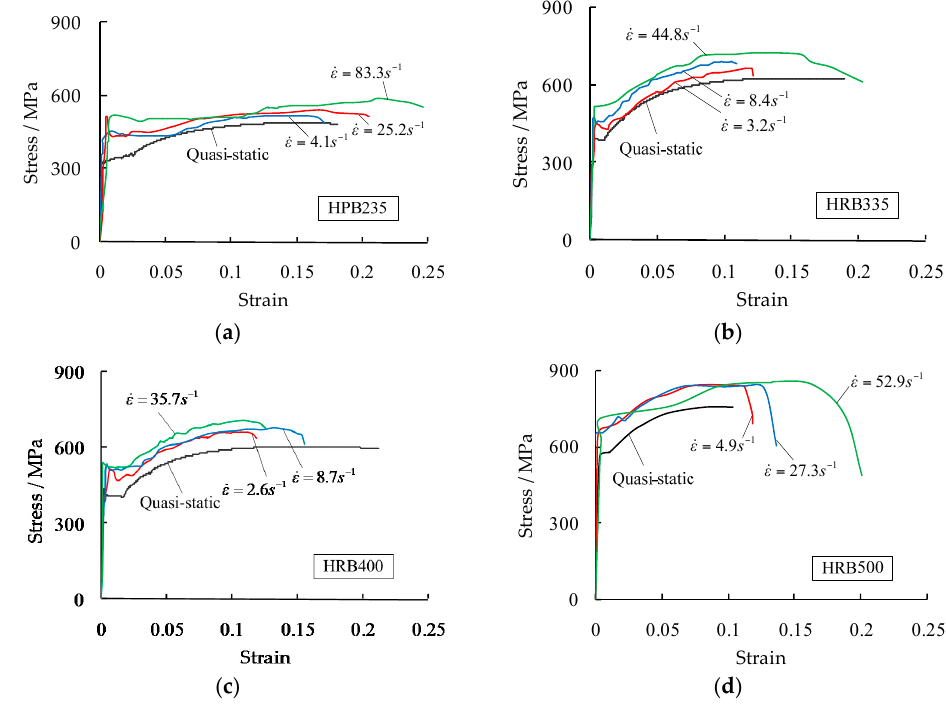
Figure 4. Typical stress-strain curves for the four rebar grades at different strain rates: ( a ) HPB235; ( b ) HRB335; ( c ) HRB400; and ( d ) HRB500. Table 2. Test results.